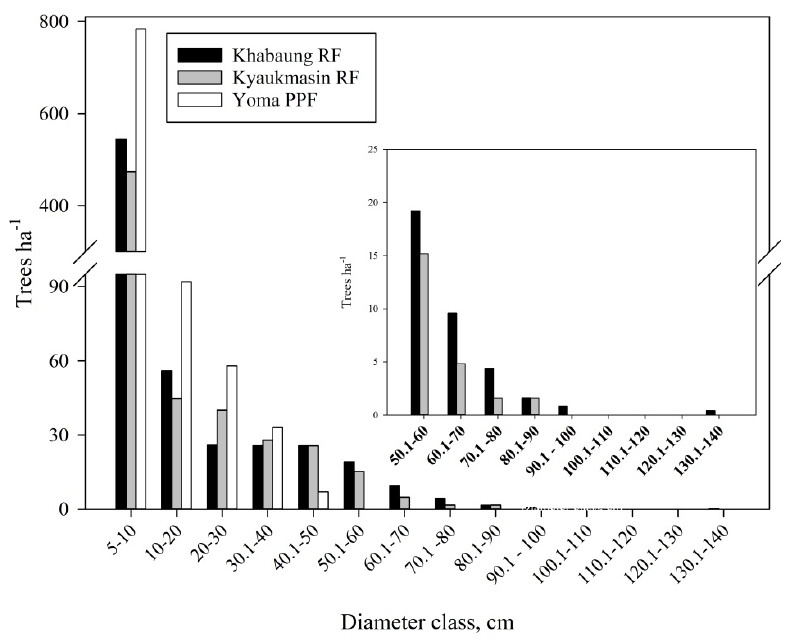
Figure 3. Diameter class distribution at the Khabaung Reserved Forest, Kyaukmasin Reserved Forest, and Yoma Protected Public Forest study sites. The inset shows the distribution of trees >50 cm DBH more clearly.